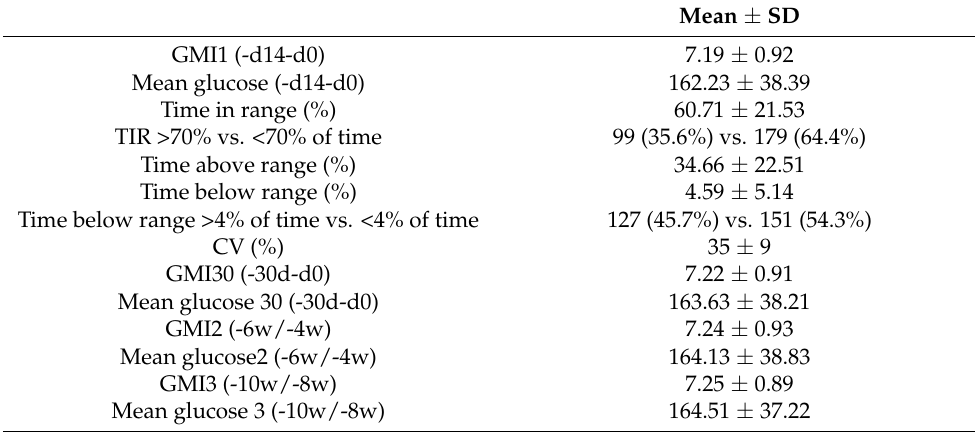
Table 2. CGM characteristics; (w: week; CV: coefficient of variance).